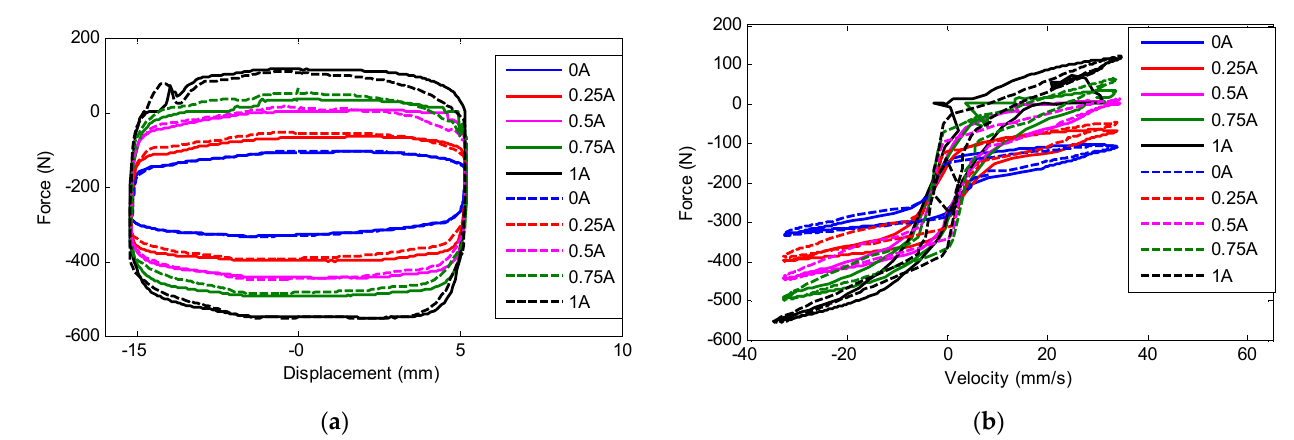
Figure 7. Comparisons of the simulation results with experimental results: ( a ) the displacement − force characteristic curves for different control currents under the harmonic excitation of 5 mm 1 Hz; ( b ) the velocity − force characteristic curves for different control currents under the harmonic excitation of 5 mm 1 Hz.